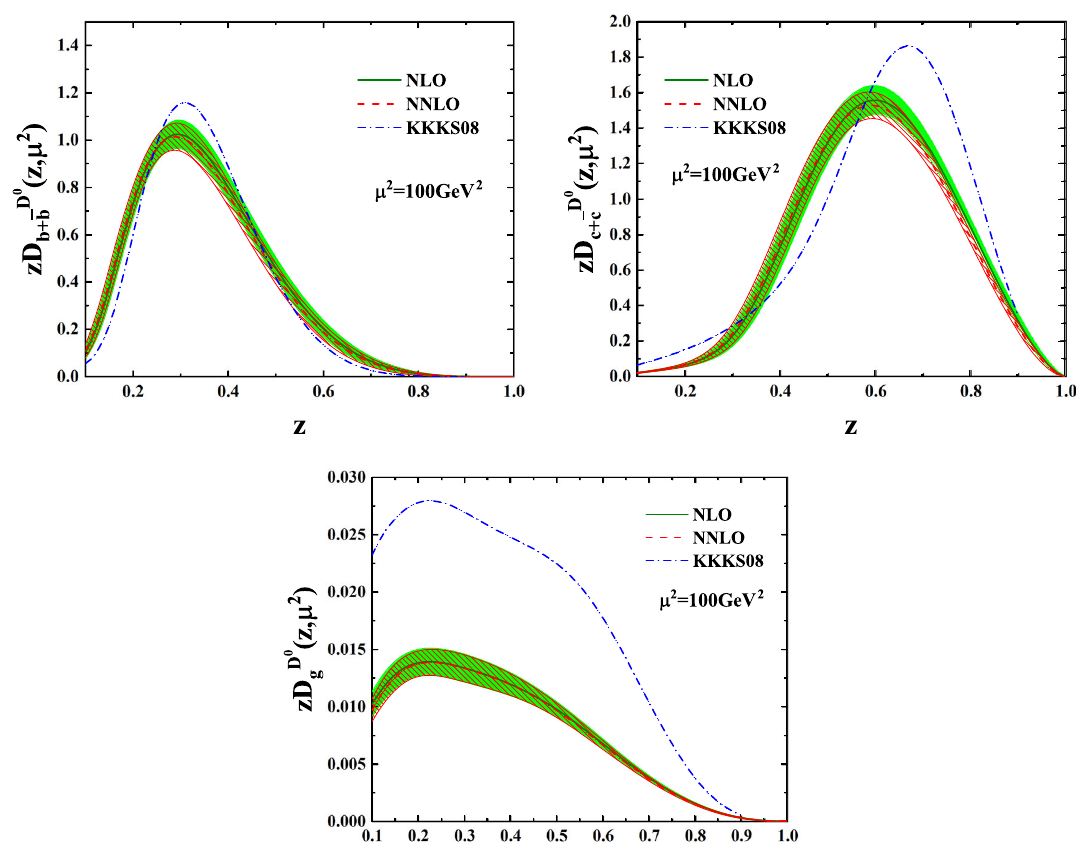
Fig. 1 The b + ¯ b , c + ¯ c and gluon FFs obtained at NLO (solid lines) and NNLO (dashed lines) QCD analyses of D 0 meson